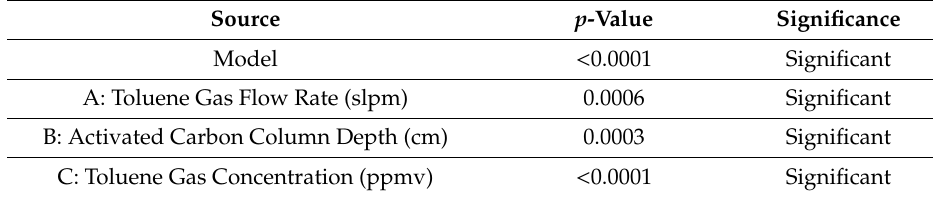
Table 5. Significance related details for the logarithmic linear toluene breakthrough RSM model.